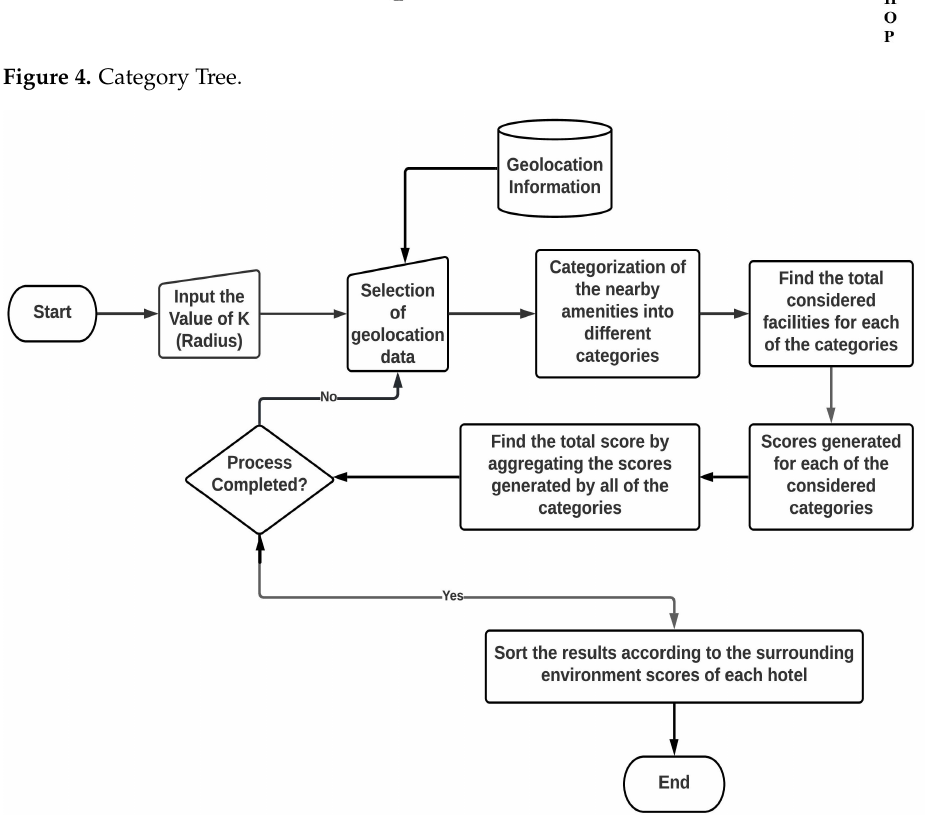
Figure 5. Score Generation Procedure from Surrounding